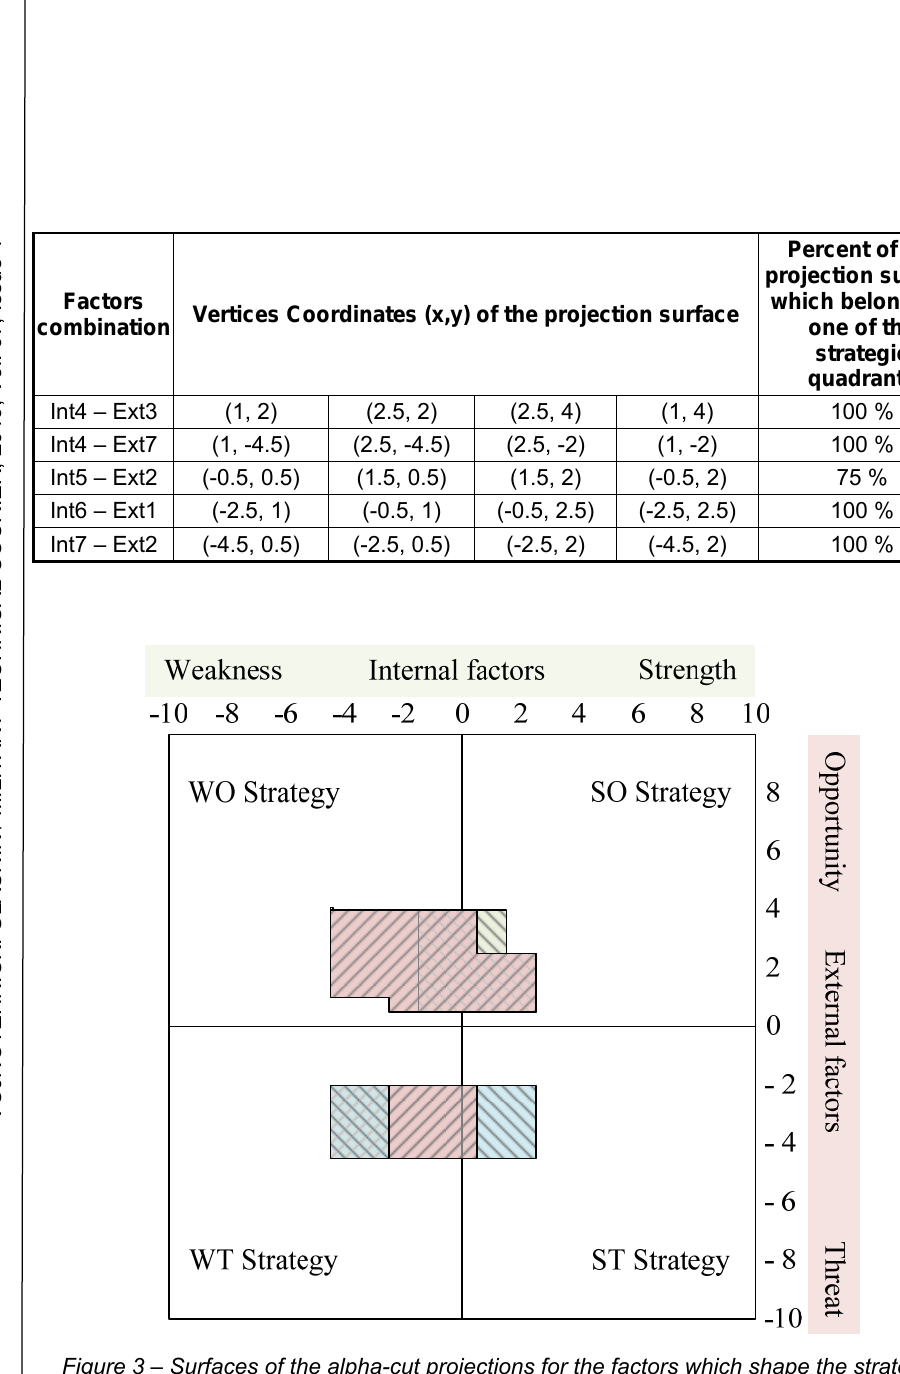
Figure 3 – Surfaces of the alpha-cut projections for the factors which shape the strategic